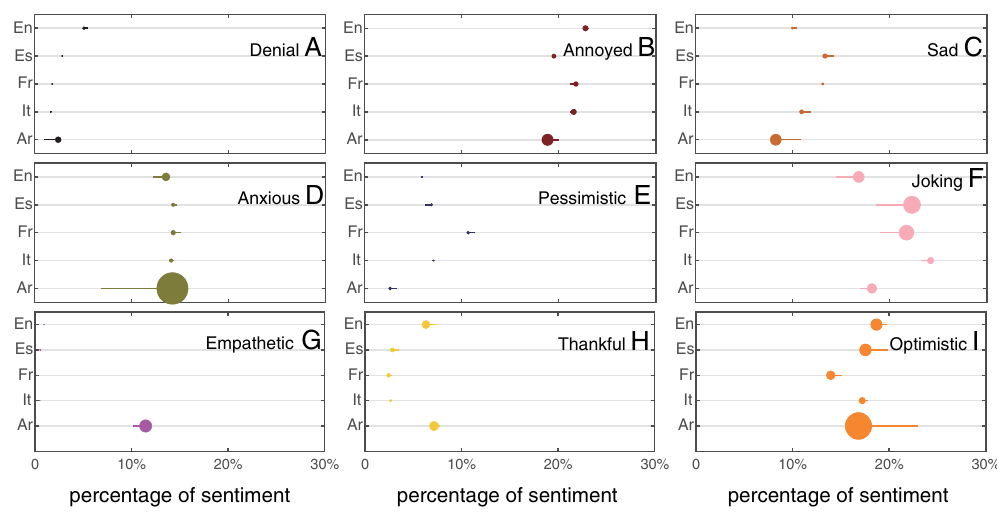
Fig. 3 Comparison of sentiment variations across languages. A – I Mean of daily sentiment in each category for each language. The symbol size is proportional to the standard deviation (ampli fi ed ten times to be visible) attached with a line indicating increase (pointing right) or decrease (pointing left) over time. The length of the line is proportional to the steepness of the linear line fi tting one sentiment curve over days, i.e., the slope in % per day (ampli fi ed 30 times to be